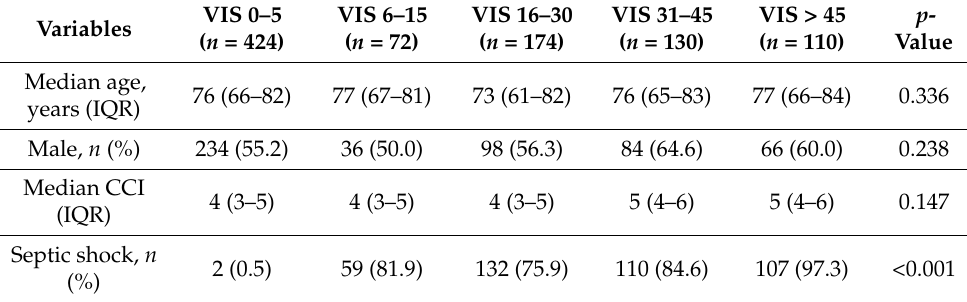
Table 2. Clinical characteristics according to each VIS